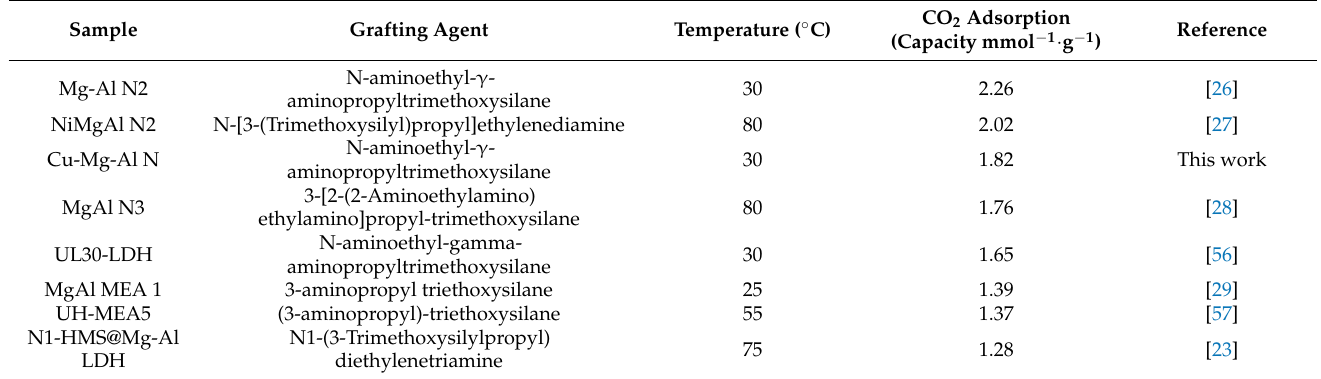
Figure 8. CO 2 adsorption capacities of xCu-Mg-Al N and xCu-Mg-Al DS/N with different temperatures. For a comparison, the CO 2 adsorption capacities for the amine-modified LDHs, as reported in the literature, are listed in Table 3, where it can be seen that the CO 2 adsorp- tion capacity of Cu-Mg-Al N was either better or comparable with those of many other materials investigated. Table 3. CO 2 adsorption capacities for the amine-modified layered double hydroxides (LDHs), as cited in the